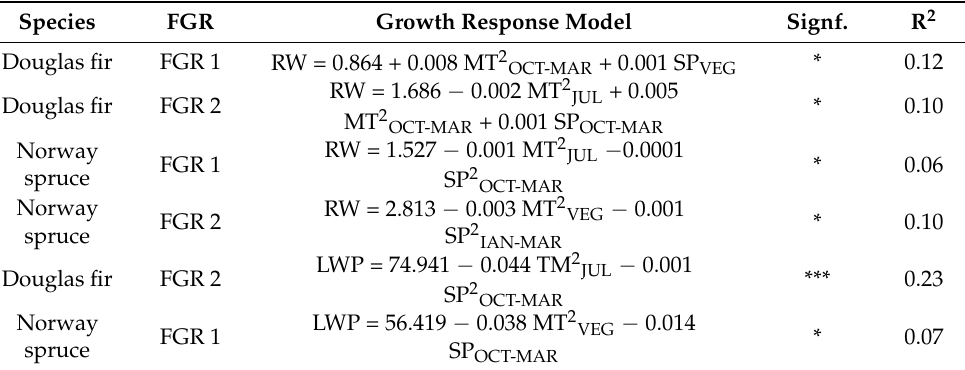
Table 7. Climatic response models for radial growth (RW) and latewood percentage (LWP) of Douglas fir and Norway spruce.